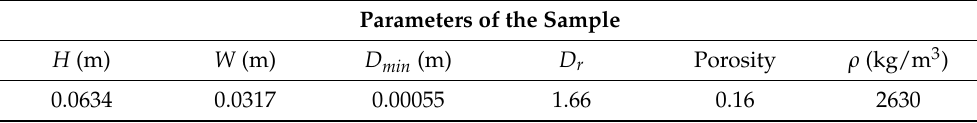
Table 1. Parameters of the virtual sample. H, W, D min , D r , and ρ are the sample height, sample width, minimum disc diameter, maximum to minimum disc diameter ratio, and density of the